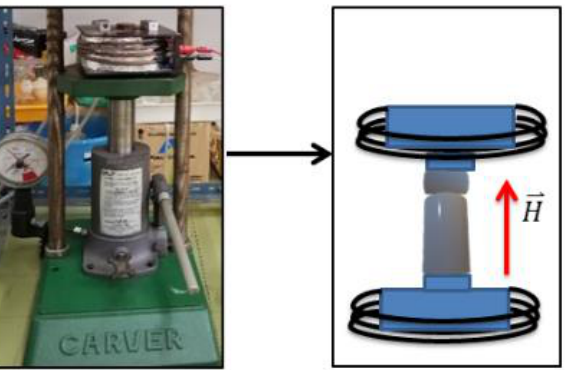
Figure 1. An instrument used to modify compression under the magnetic field-assisted process, and a magnetic field direction simulation.